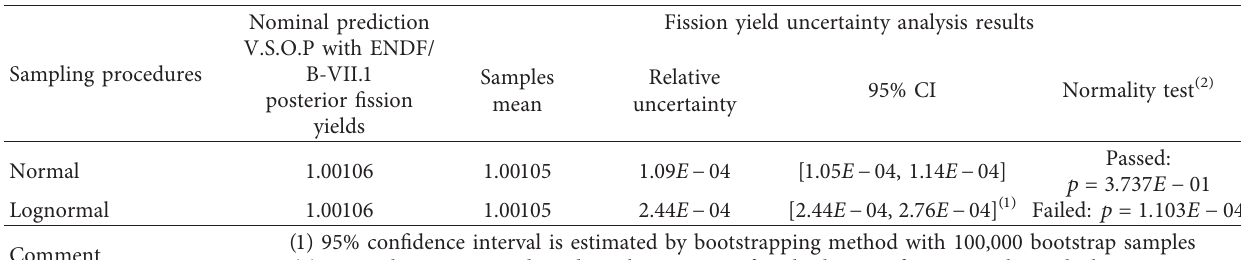
Table 6: Uncertainty analysis results and comparison of multiplication factor at equilibrium core